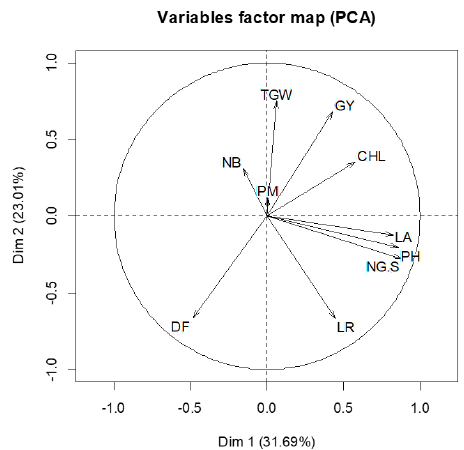
Figure 3. Biplot showing the correlation among total chlorophyll content (CHL), number of days to flowering (DF), plant height (PH), number of grains/spike(NG/S),1000-grain weight (TGW), leaf rust